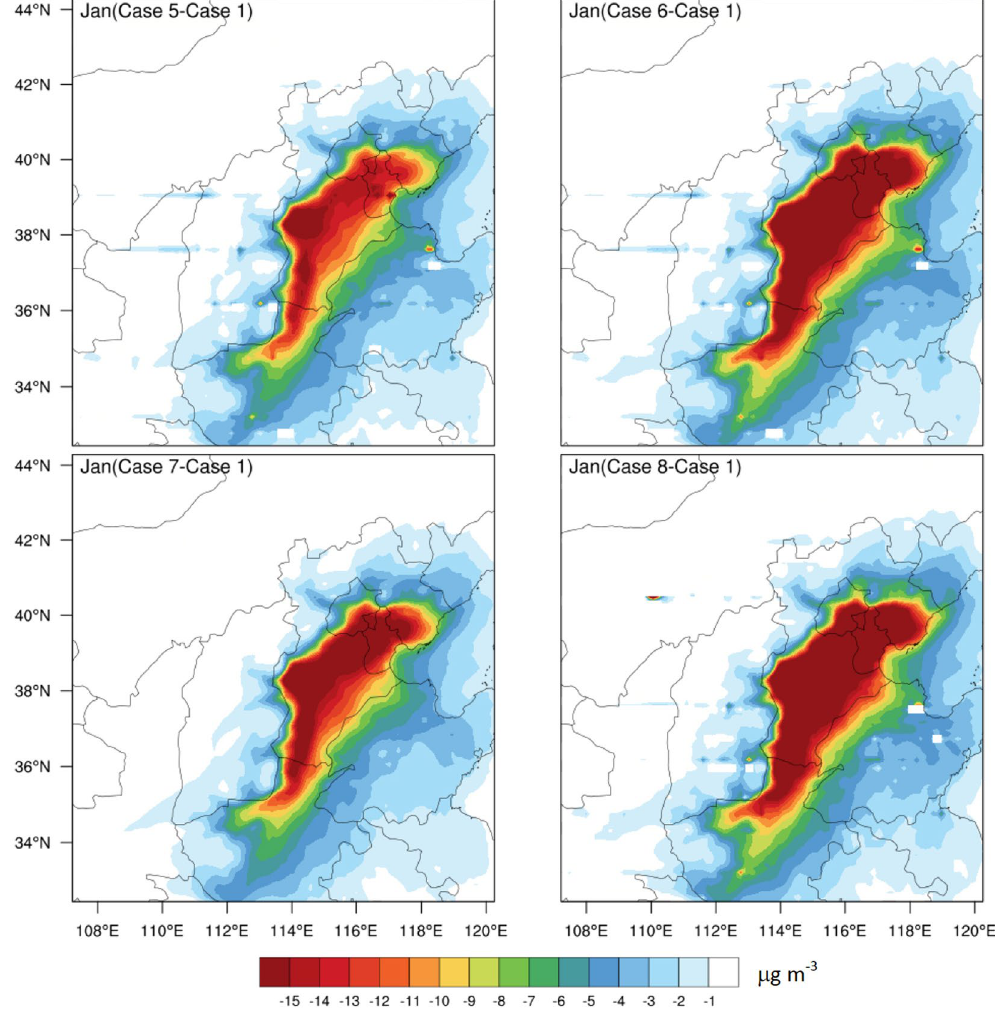
Figure 5. Distribution of predicted monthly mean reductions of PM 2.5 ( µ g m − 3 ) for Cases 5, 6, 7, and 8 relative to that of Case 1 in January 2013. The maps were created by NCAR Command Language (NCL) (http://www.